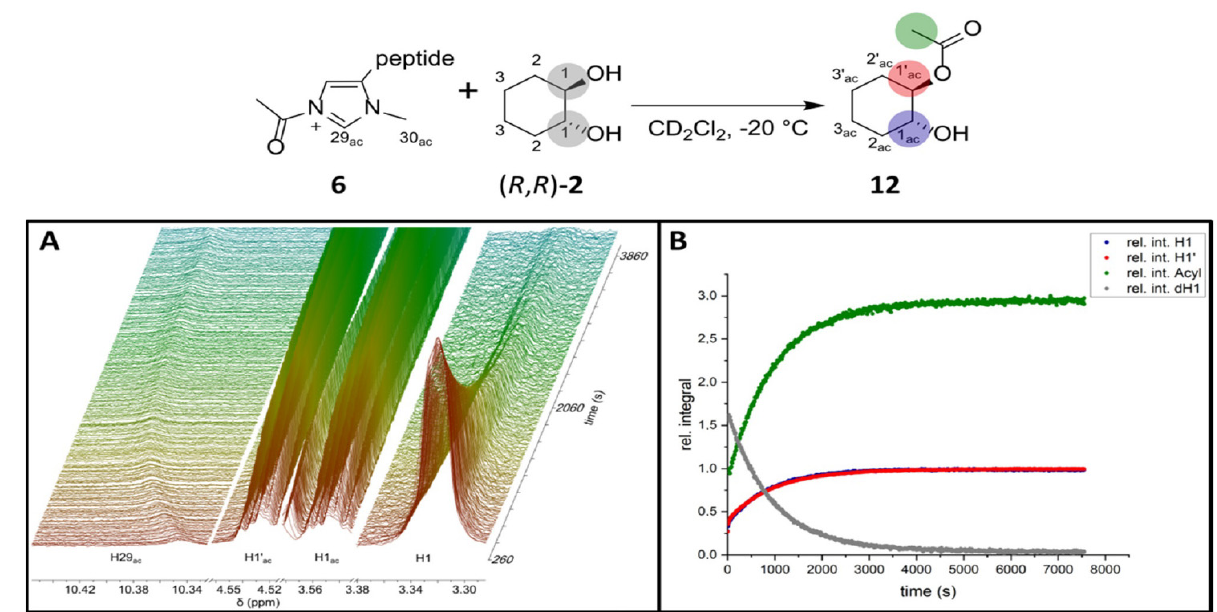
Figure 8. Stacked 1 H − spectra excerpts (700 MHz 1 H frequency) showing the course of the reaction for the selected signals H29 ac , H1 ′ ac , H1 ac and H1 ( A ). Reaction profile of the acyl transfer from 6 for the selected signals H29 ac , H1 (cid:48) ac , H1 ac and H1 ( A ). Reaction profile of the acyl transfer from 6 onto 2 in DCM − d 2 at –20 °C ( B ). onto 2 in DCM − d 2 at − 20 ◦ C ( B